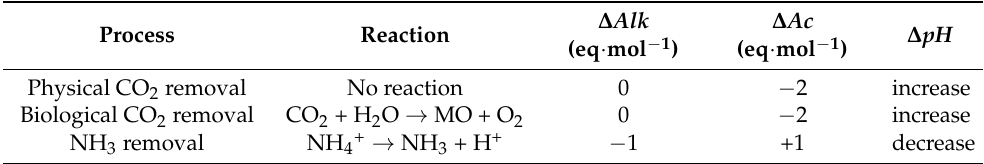
Table 1. Effect of the different processes on alkalinity and acidity and, consequently, the pH in polishing ponds. Process